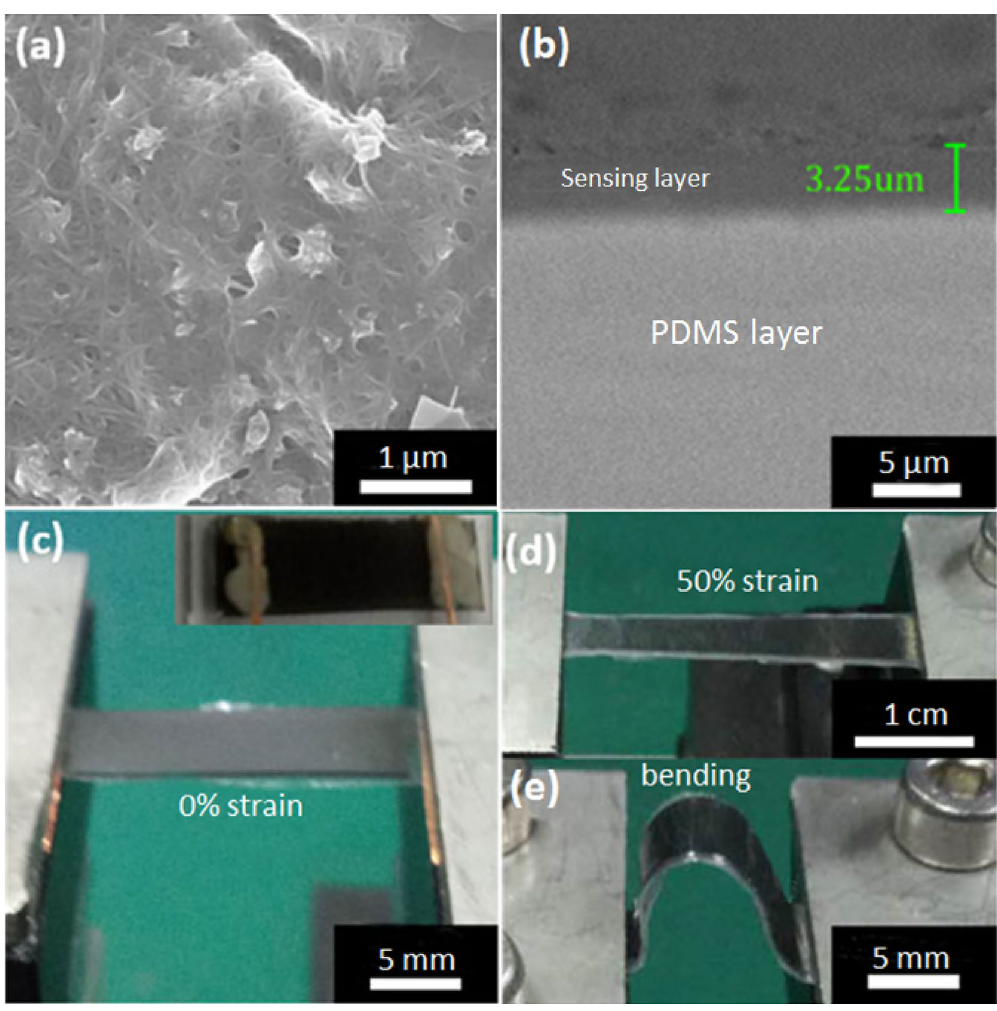
Figure 4. ( a ) Photograph of the GNP-CNT hybrid thin film strain sensor. ( b ) SEM image of GNP-CNT hybrid thin film, showing the cross-section view. ( c – e ) Photographs of a GNP-CNT hybrid thin film strain sensor at its original length and 50% of stretching and bending of strain sensor, showing the superb stretchability of the